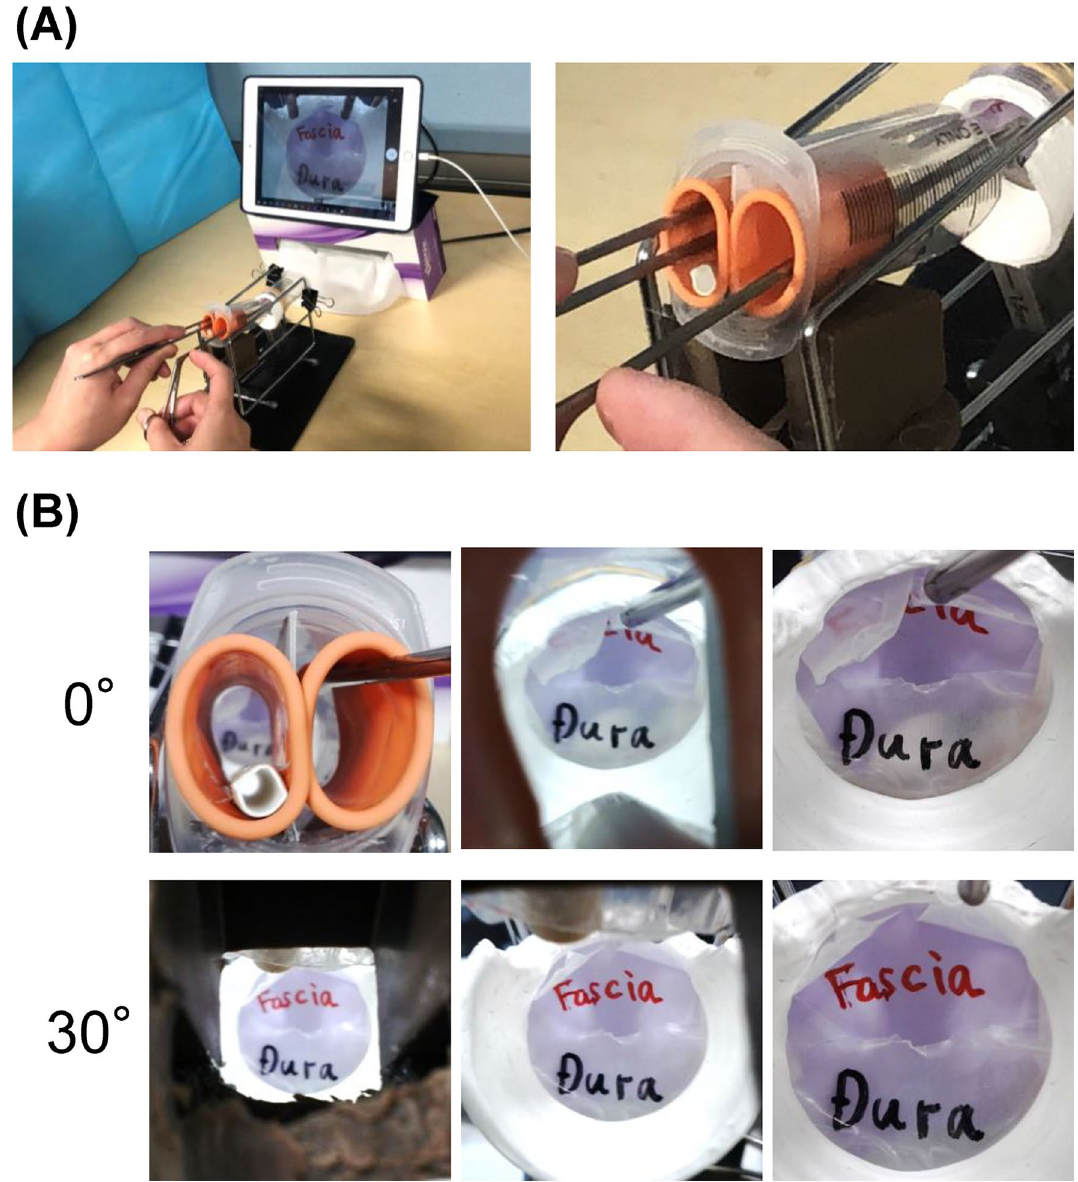
Figure 4. Training with equipment. ( A ) Left panel, Training with equipment; right panel, enlarged view at hand. ( B ) The image captured by the stick-type camera. Upper and lower panels, the 0° and 30° views,